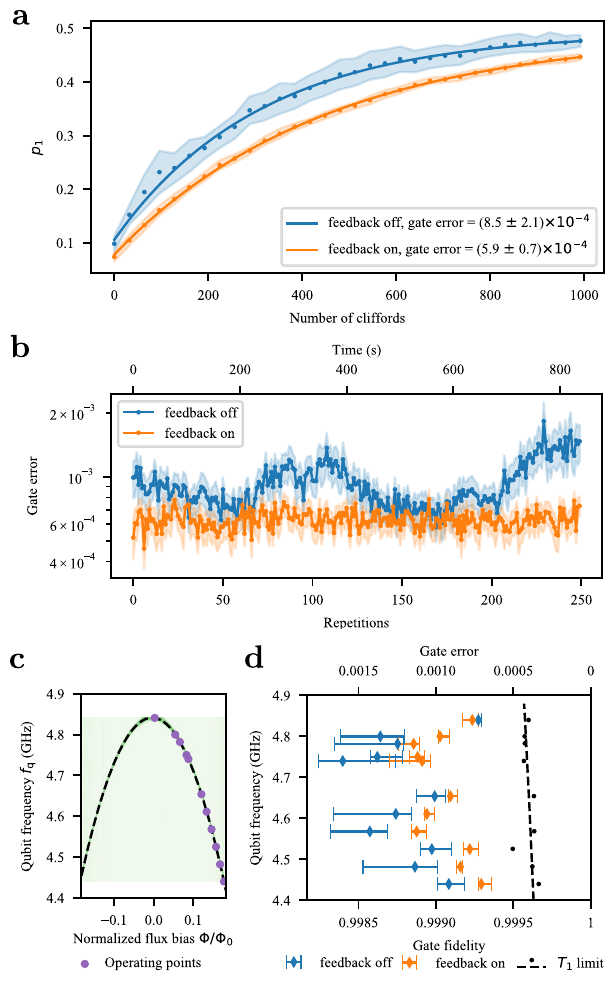
Fig. 4 Randomized benchmarking. a Randomized benchmarking of the single-qubit gates at f q = 4.44 GHz. The orange (blue) dots show the average of 50 realizations of the random Clifford sequences with (without) the feedback. The shaded area shows the 68% con fi dence interval for the average trajectory. The gate error is extracted from the fi t to the data (solid line). b Randomized benchmarking is repeated 250 times with the feedback (orange dots) and then without (blue dots). The shaded area shows the 68% con fi dence interval for the fi tted gate error. c The qubit spectrum and the operating points at which the gate errors are evaluated in ( d ). d Randomized benchmarking at several different qubit bias fl uxes. Black dots show the estimated coherence limit for the gate fi delities, inferred from the energy- relaxation time T 1 of the qubit 33 . The dashed black line shows a linear fi t to the estimated coherence limits at the different operating points. The error bars are the 68% con fi dence intervals for the median gate errors, such as the quasi-static shifts in the qubit frequency due to the low-frequency noise. In contrast, with the feedback activated, the function monotonically decays for all random sequences, something that is typical for incoherent errors 35 – 39 . This observation is supported by the experiment in Fig. 4b where we show the gate errors inferred from randomized benchmarking experiments repeated 250 times with seven different realizations of a random gate sequence, for a total duration of 840 s. Without the feedback, we observe a signi fi cant drift in the gate errors. With feedback turned on, the gate errors remain consistently low, indicating that the feedback successfully stabilized the drift and fl uctuations in the qubit frequency. This is also manifested in lowered uncertainty in the fi tted gate error in Fig. 4a.